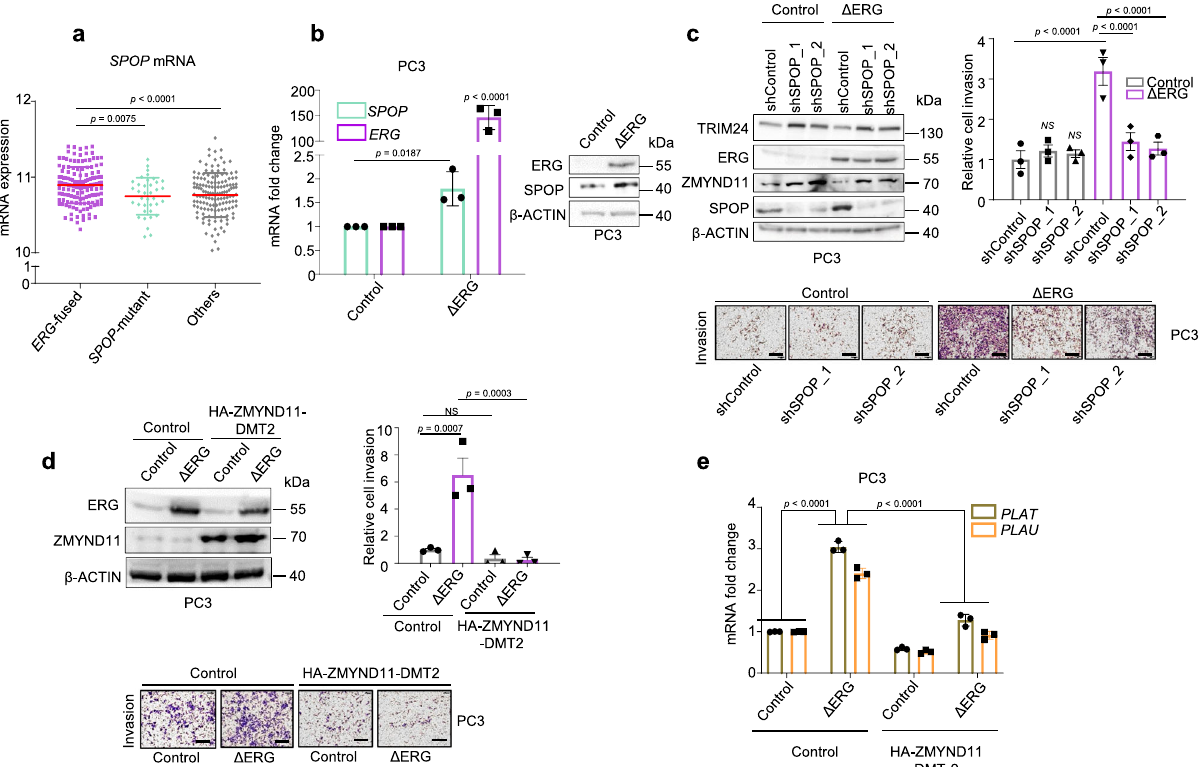
Fig. 6 SPOP-WT is an ERG target gene and required for ERG-mediated cell invasion. a SPOP mRNA expression levels in 333 primary prostate cancer tissues strati fi ed according to the indicated driver mutations 3 . Error bars, mean ± s.d. b SPOP mRNA and protein levels in response to forced expression of Δ ERG in PC3 prostate cancer cells by qPCR and immunoblotting, respectively. Error bars, mean + s.e.m. ( n = 3). P -values were determined by unpaired, two-tailed Student ’ s t -test. Control vs. Δ ERG for SPOP expression levels. Control vs. Δ ERG for ERG expression levels. c Transwell Matrigel invasion assay of PC3 cells with forced expression of Δ ERG and knockdown of SPOP using two different short-hairpin RNAs. Protein expression of the indicated proteins was assessed in parallel by immunoblotting. Error bars, mean ± s.e.m. ( n = 3) (bar represents 400 µ m). d Transwell Matrigel invasion assay of PC3 cells with forced expression of Δ ERG and HA-ZMYND11-DMT2 and corresponding immunoblot analysis. Error bars, mean ± s.e.m. ( n = 3) (bar represents 400 µ m). e Analysis of the Δ ERG- and HA-ZMYND11-DMT2-induced transcriptional changes in the ERG target genes PLAU and PLAT . All error bars, mean ± s.e.m. P - values were determined by one-way ANOVA with multiple comparisons and adjusted using Benjamini – Hochberg post-test ( a , c , d , e ). NS, not signi fi cant. Molecular weights are indicated in kilodaltons (kDa). Source data are provided as a Source Data